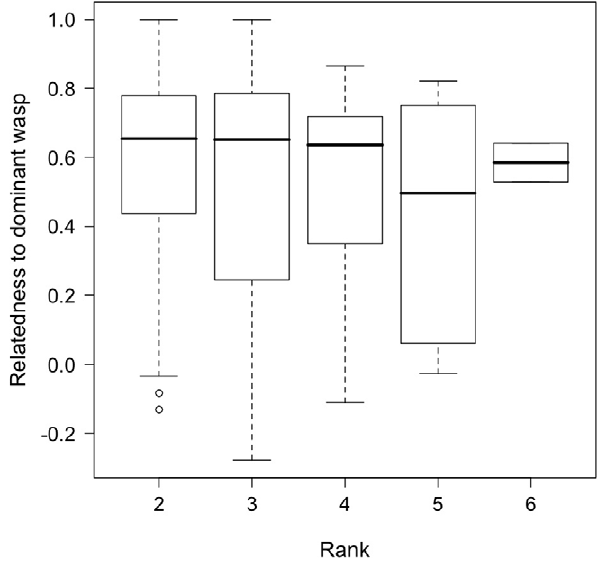
Figure 3. Inheritance rank in relation to a subordinate’s relatedness to the dominant wasp. Medians, interquartile range and max/min values are indicated.